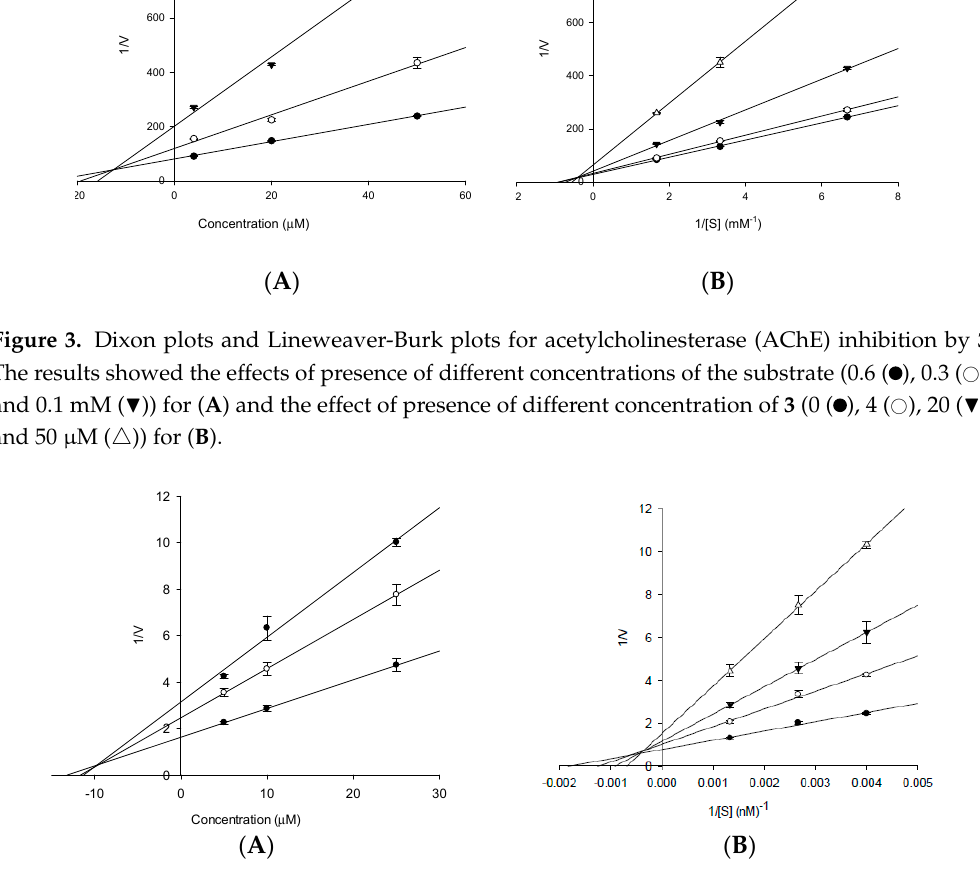
Figure 4. Dixon plots and Lineweaver-Burk plots for β -site amyloid precursor protein-cleaving enzyme 1 (BACE1) inhibition by 4 . The results showed the effects of presence of different concentrations of the substrate (252 ( ● ), 375 ( ○ ), and 750 nM ( ▼ )) for ( A ) and the effect of presence of different concentration of 4 (0 ( ● ), 5 ( ○ ), 10 ( ▼ ), and 25 µM ( △ )) for ( B ).